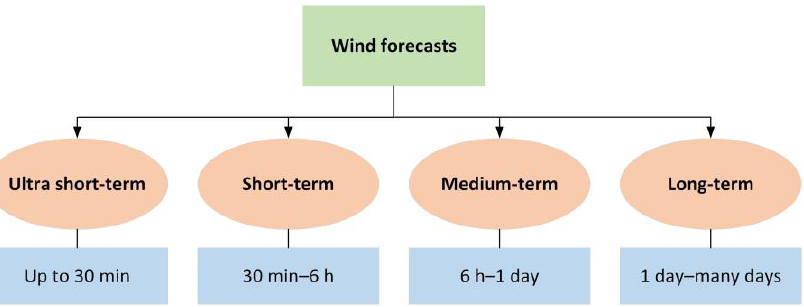
Figure 3. Classification of wind forecasts based on a temporal scale.